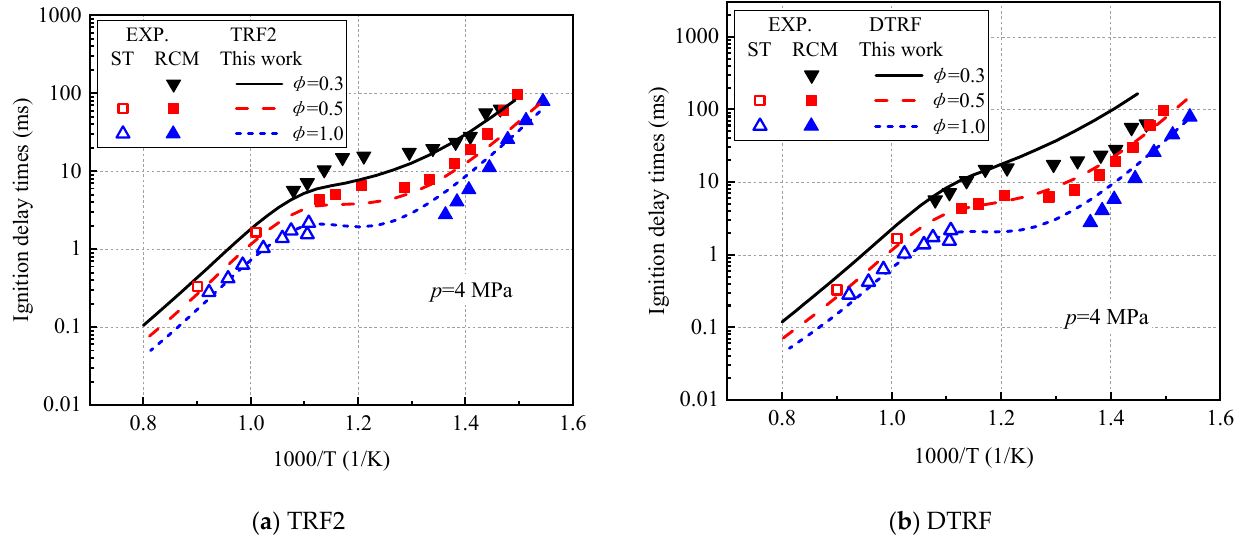
Figure 14. Comparison of ignition delay calculated by RD387 gasoline experiment [43,47] and model. ( a ) TRF2 and ( b ) DTRF.